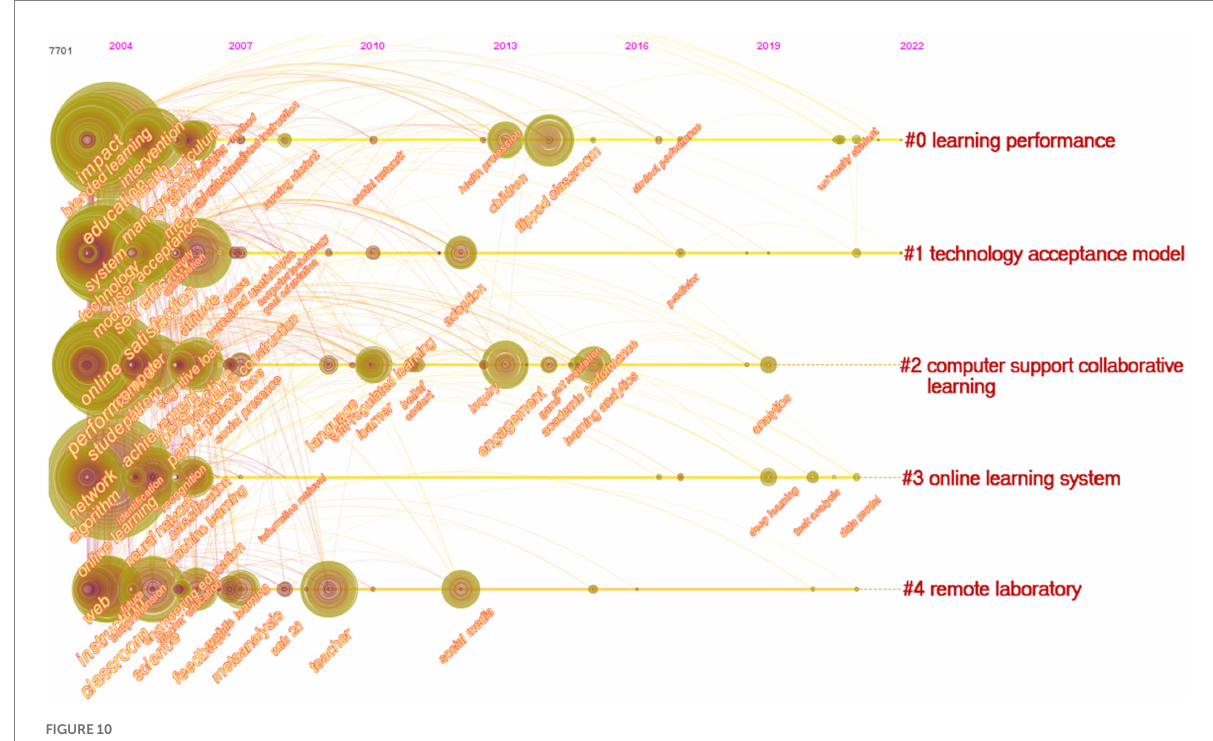
FIGURE 10 Burst trends of research